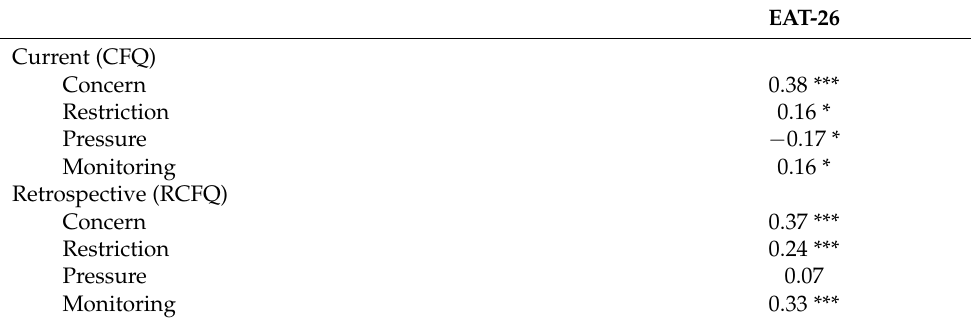
Table 2. Pearson correlations between parent’s current disordered eating (EAT-26), current CFP and retrospectively recalled maternal CFP, after controlling for BMI; subscale means and SDs (N =